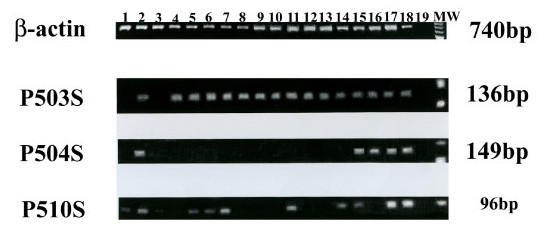
Analysis of gene expression levels of p503S, p504S and p510S by RT-PCR using β-actin yielded a 740 base-pair band as internal control in frozen benign (lanes 1, 3, and 6) and neoplastic (lanes 2, 4, and 5) prostatic tissue; non prostatic tissue (adrenal gland (lane 7); heart (lanes 8 to 10); myometrium (lane 11); uterine cervix (lane 12) and human cell lines: SV48 (lane 13); LS147D (lane 14); SCOV 3 (lane 15); MCF7 (lane 16); PC3 (lane 17); and LNCaP (lane 18). Negative control no RNA (lane 19); MW (molecular weight).